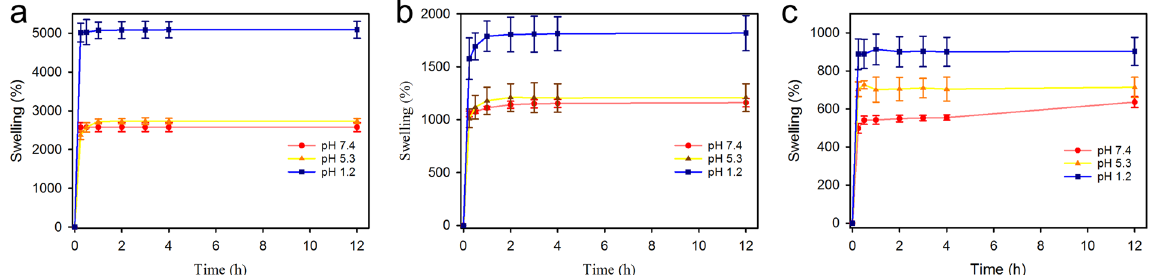
Figure 2. Swelling behaviors of dendrimer cryogels at 37 °C. ( a ) Effect of pH on the swelling of CG-G4-1%. ( b ) Effect of pH on the swelling of CG-G4-5%. ( c ) Effect of pH on the swelling of CG-G4-10%.